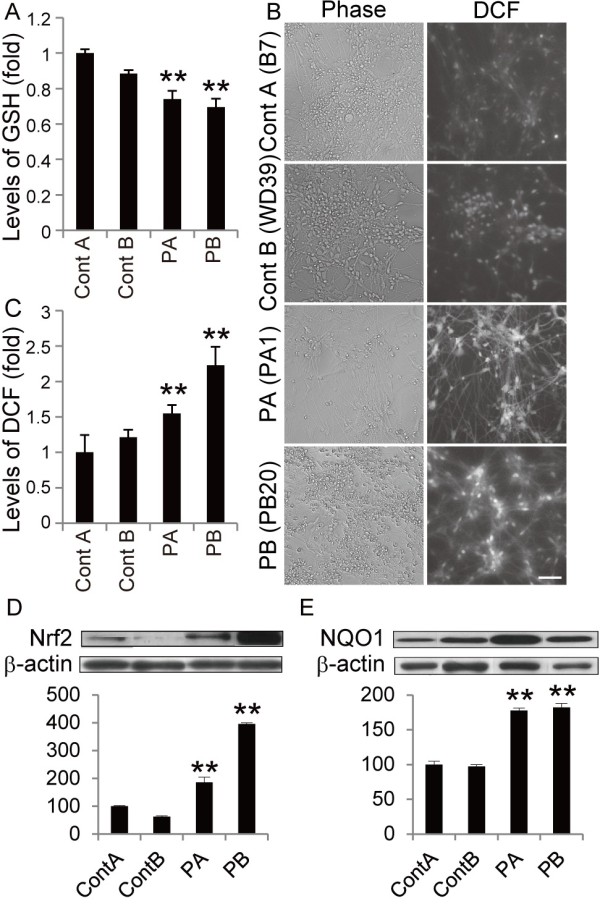
Increased oxidative stress accompanied by activation of the Nrf2 pathway in PARK2 iPSC-derived neurons. (A) GSH levels were significantly reduced in PARK2 (PA1, 9 and 22, and PB2, 18 and 20) iPSC-derived neurospheres compared with those in control A (YA9) and B (WD39) neurospheres. (B, C) DCF fluorescence intensity in PARK2 (PA1, 9 and 22, and PB2 and 20) iPSC-derived neurons was significantly higher than that in control A (B7) and B (WD39) neurons. (D, E) Immunoblot analysis of Nrf2 and NQO1 levels in iPSC-derived neurons from PA and PB. Expression of Nrf2 and NQO1 in PARK2 (PA9 and PB2) iPSC-derived neurons was significantly higher than that in control A (YA9) and B (WD39) neurons. Relative protein abundance was normalized to β-actin. ** indicates P < 0.01 (Mann–Whitney U-test). Data represent the mean and SEM of at least three experiments for each group.